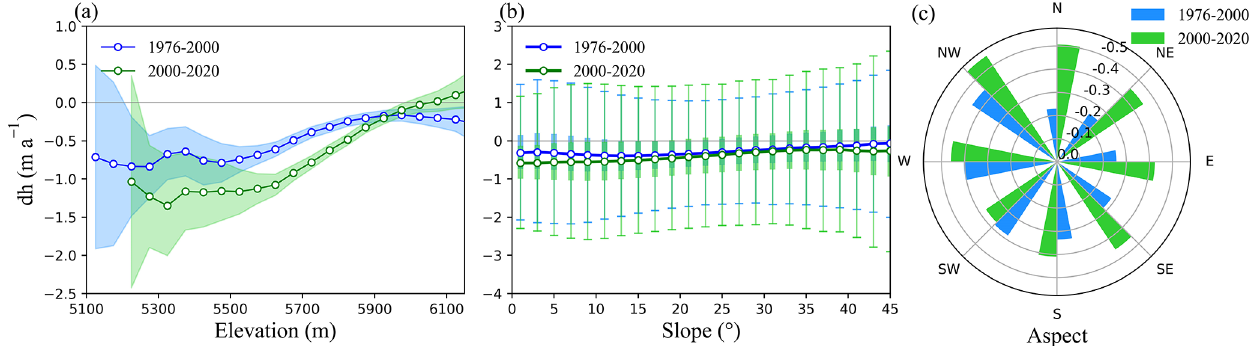
Figure 8. Glacier elevation change from 1976 to 2000 and from 2000 to 2020 with (a) elevation, (b) slope and (c) aspect. The dots in panel (a) represent the mean elevation change in each 50m bin, and shaded regions in (a) indicate the uncertainty in the altitudinal distributions. Panel (b) is the boxplot of elevation change in 2 ◦ slope bins, and four lines from the bottom to top for one box represent minimum value, 25th percentile, 75th percentile and maximum value, respectively, and dots in panel (c) represent the mean elevation change in each 2 ◦ slope bin. Panel (c) represents the mean elevation change in each 45 ◦ aspect